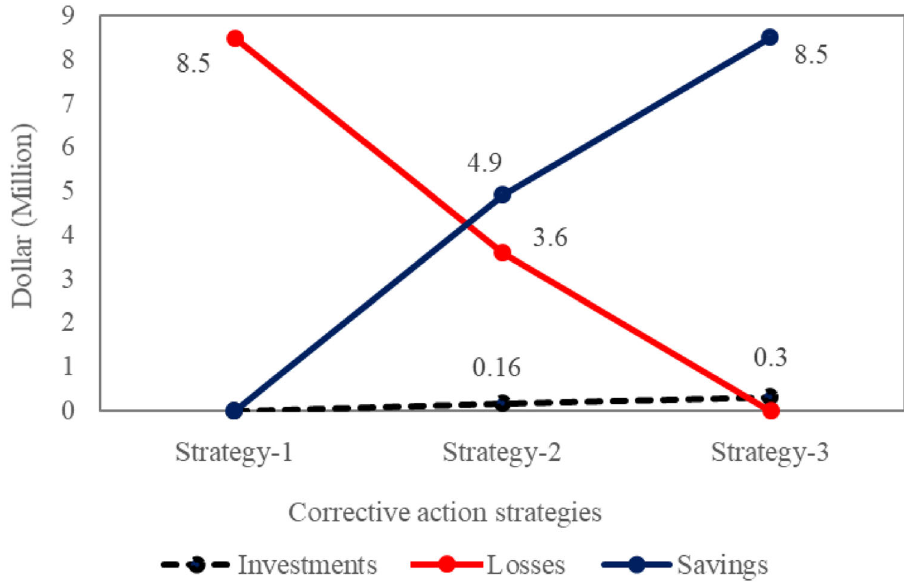
Fig. 6 Comparison of